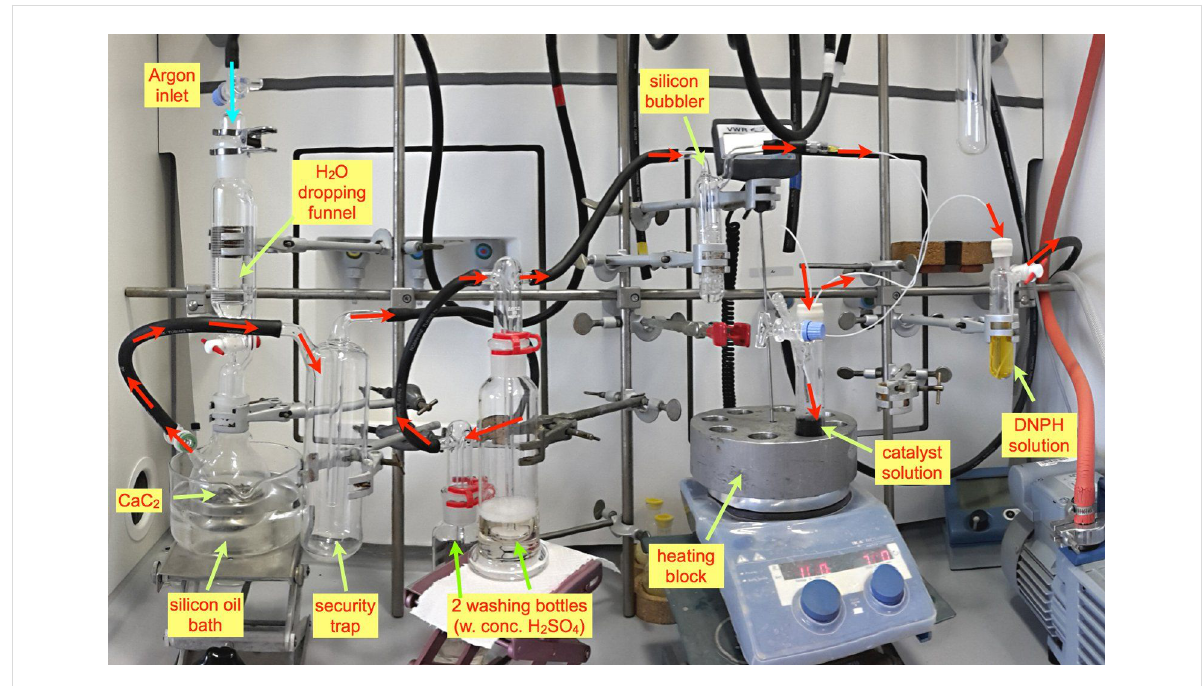
Figure 2: Experimental setup for the study of catalytic acetylene hydration. Red arrows indicate the direction of the gas flow.